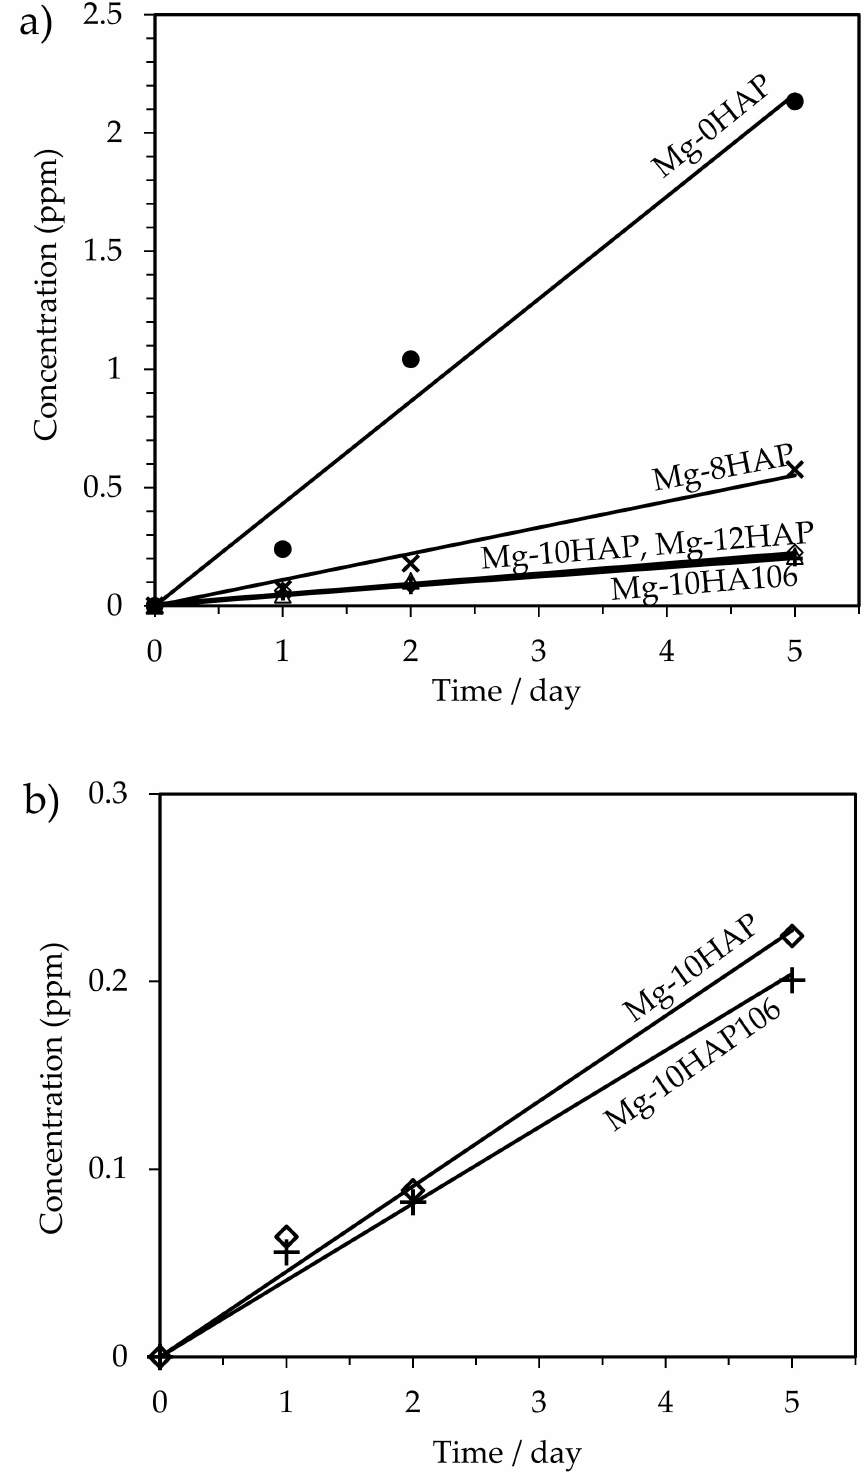
Figure 10. Mg concentration released from each sample after immersion test. ( a ) comparison of all samples and ( b ) enlarged view of data from samples Mg–10HA and